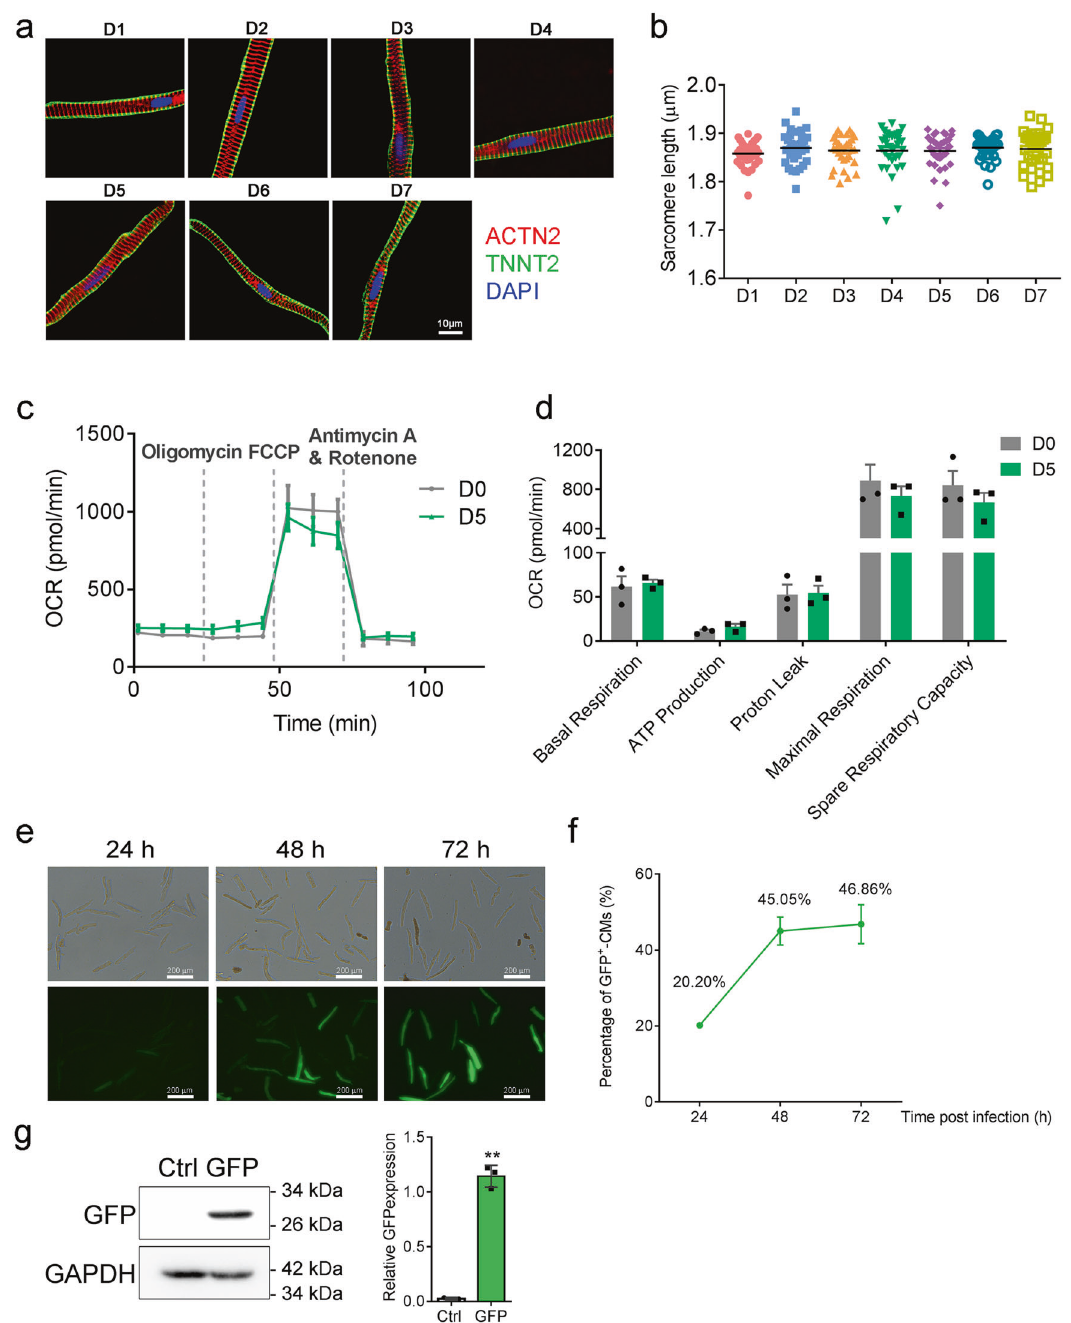
Fig. 4 Structural and functional evaluation of hPCMs in culture. a Immuno fl uorescence of cardiac markers ACTN2 (red) and TNNT2 (green) during hPCM culture until D7. Images are representative of three independent experiments. b Quanti fi cation of sarcomere lengths in a . c Measurement of oxygen consumption rates of freshly isolated hPCMs (D0) and cultured hPCMs (D5) by Seahorse assay. Data were mean ± SEM, from three independent experiments ( d ) Quanti fi cation of c . e Infection of cultured hPCMs with GFP-expressing adenovirus. Images are representative of three independent experiments. f Quanti fi cation of GFP-expressing cells for the fi rst 72 h post-infection. Data were mean ± SEM. g GFP protein expression analysis by western blotting. hPCMs were transduced by either GFP-expressing adenovirus (GFP) or empty vector control (Ctrl), and protein expression was analyzed by western blotting (left). GAPDH was used as an internal control. Results are representative of three independent experiments. Right: quanti fi cation of western blots. ** P < 0.01, paired t -test Cardiotoxicity screening of targeted therapies in hPCMs agent, as well as three targeted anticancer therapeutics, Cardiotoxicity is one of the major reasons for drug attrition during including sorafenib, ponatinib, and regorafenib. None of the development and market withdrawal due to adverse cardiovascular tested drugs exhibited differences in their IC 50 values between events. 45 To facilitate the detection of cardiac toxicity early in the fresh and cryopreserved cells (Fig. 5l), suggesting the possibility of using hPCMs for high-throughput and high-content drug discovery process, hiPSC-CMs are increasingly used as an screening. in vitro platform for preclinical safety assessment. 13,46 – 48 To test the Signal Transduction and Targeted Therapy (2022)